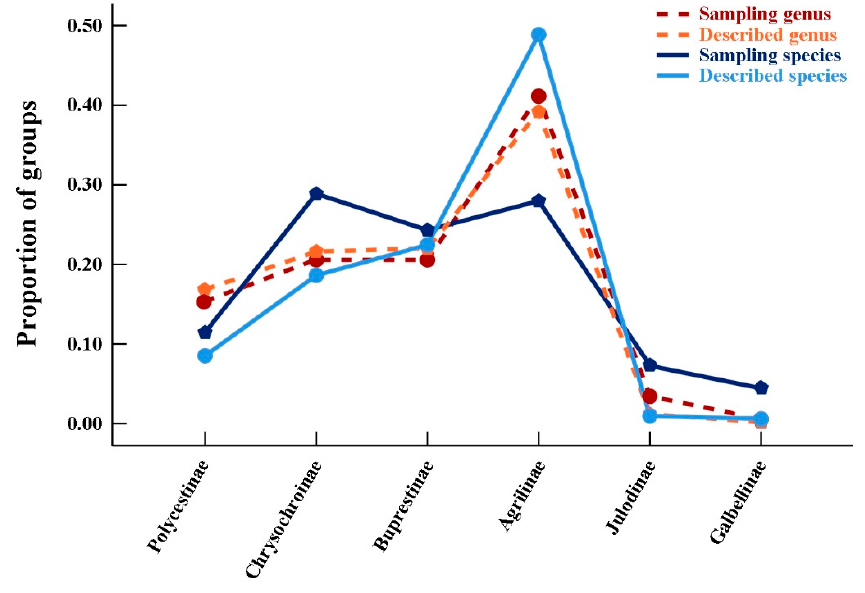
Figure 1. The proportion of genera/species under each subfamily in Buprestidae. Each proportion calculated from the sampling dataset and described dataset is showed, re-